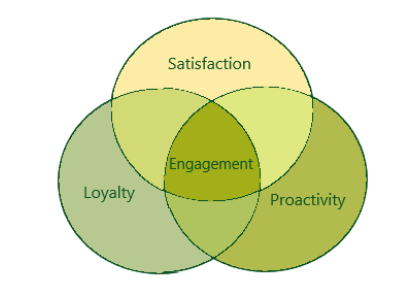
Fig. 1. Engagement